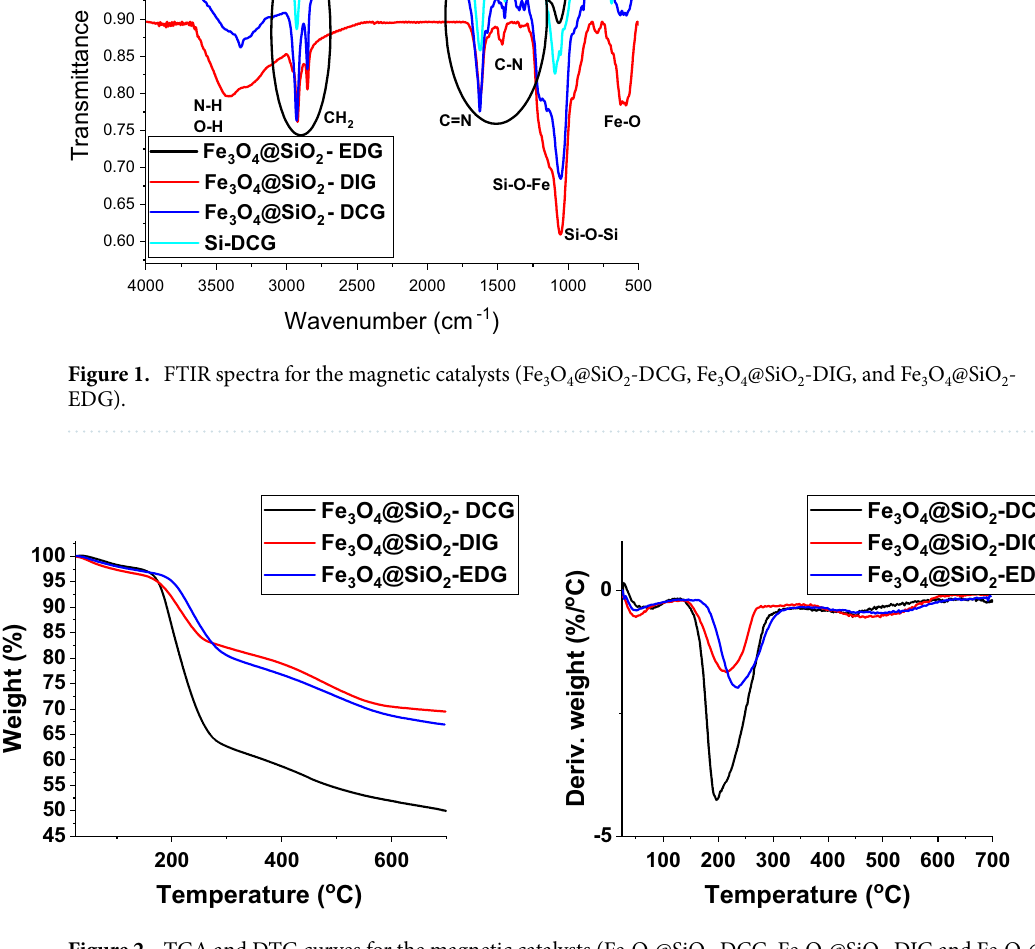
Figure 2. TGA and DTG curves for the magnetic catalysts (Fe 3 O 4 @SiO 2 -DCG, Fe 3 O 4 @SiO 2 -DIG and Fe 3 O 4 @ SiO 2